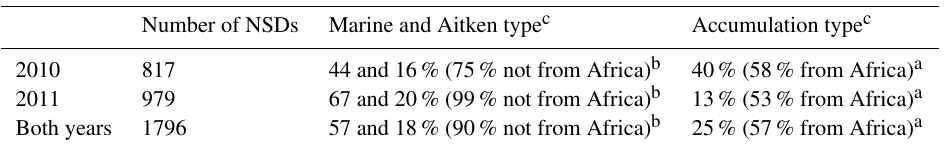
a Trajectory crossed one or both boxes representing the Sahara and the Sahel. b Trajectory did not cross either of the two boxes representing the Sahara and the Sahel. Table 4. Statistics on NSDs. (Percentages in brackets indicate, how many of those mentioned before the bracket had trajectories originating from the respective region.)